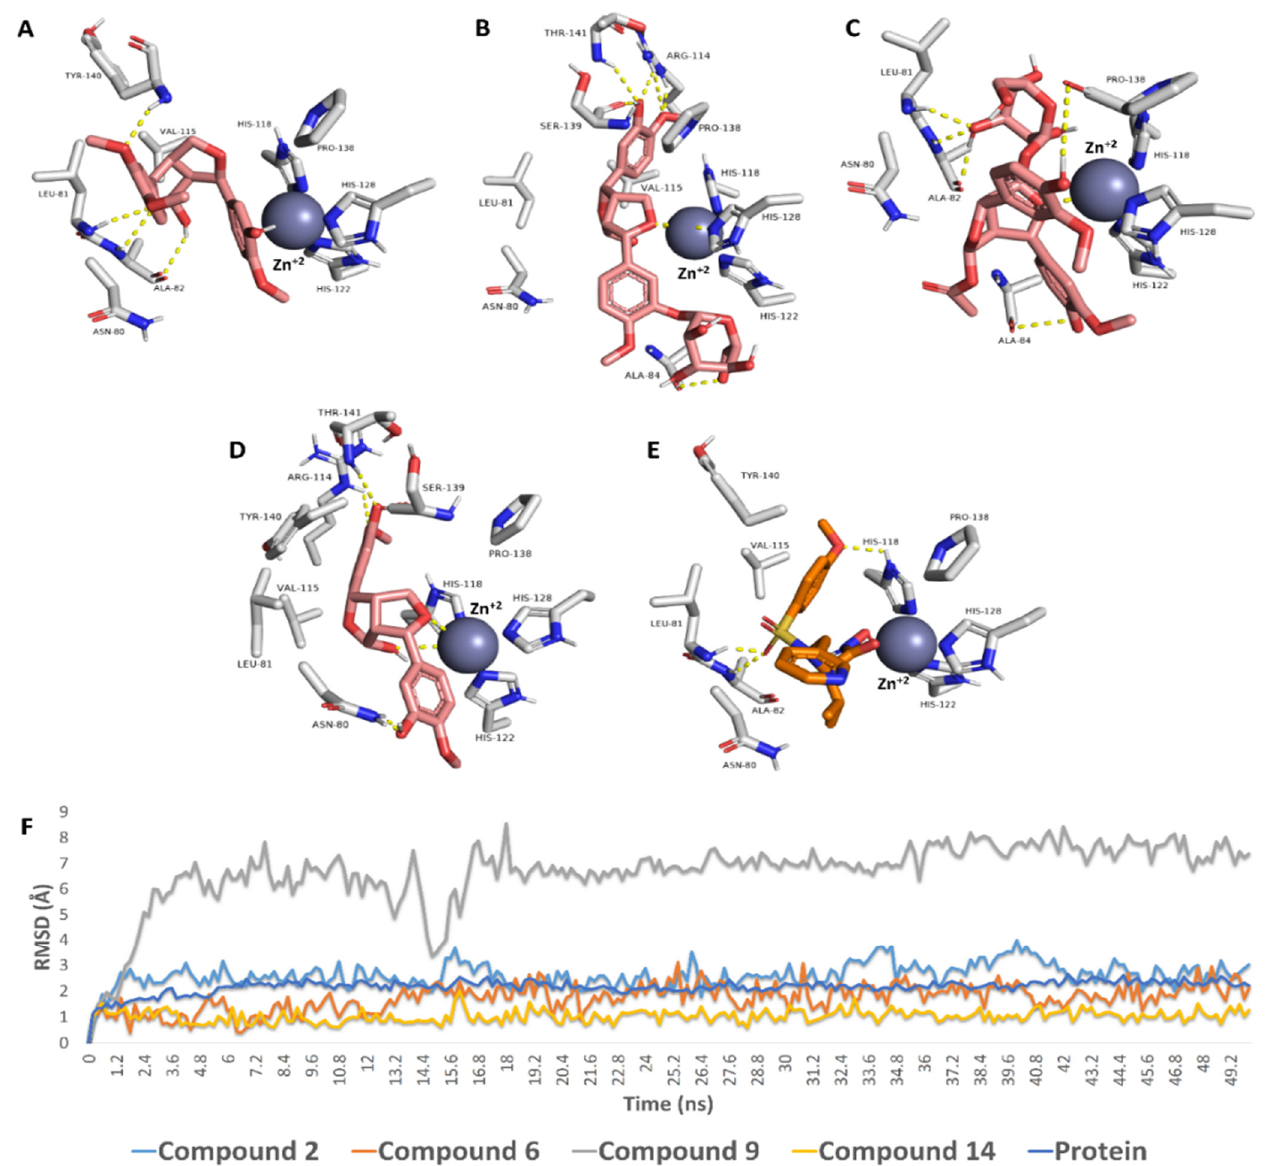
Figure 12. Binding poses of compounds 2 , 5 , 8 , and 12 within the potential active site of MMP1 ( A – E ) and that of the cocrystalized inhibitor I. The RMSDs of compounds 2 , 5 , 8 , and 12 within the F potential active site of MMP1 over 50 ns of MDS ( F ). potential active site of MMP1 over 50 ns of MDS (